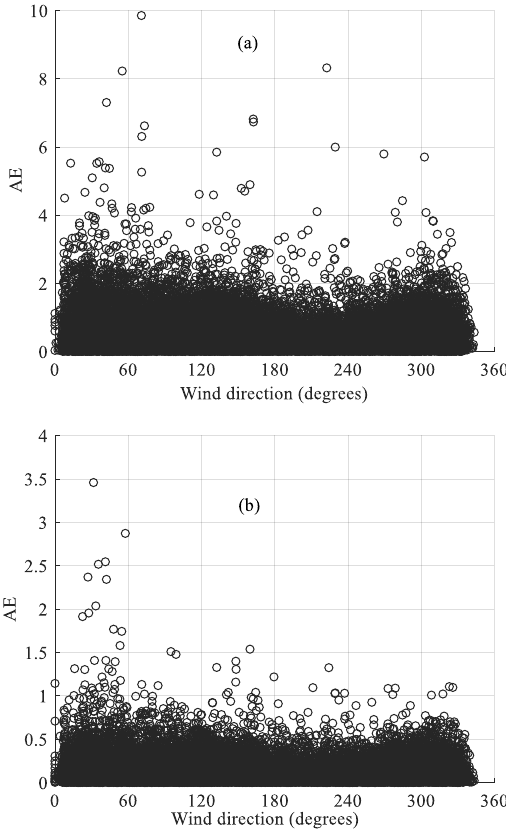
Figure 8. Absolute error per wind direction of the proposed model corresponding at ( a ) Case#2 and ( b ) Case#5 of the 1-min-ahead prediction horizon.